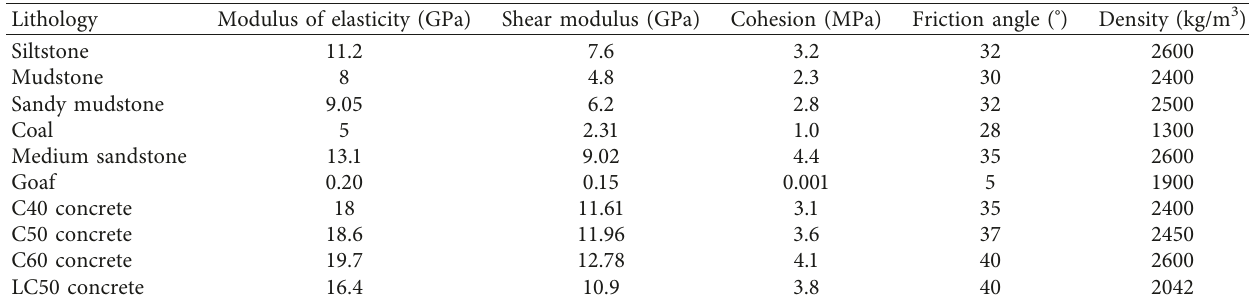
Figure 13: (a) Numerical simulation model, (b) boundary conditions, and (c) layout of measuring points. Table 7: Mechanics parameters of coal and rock